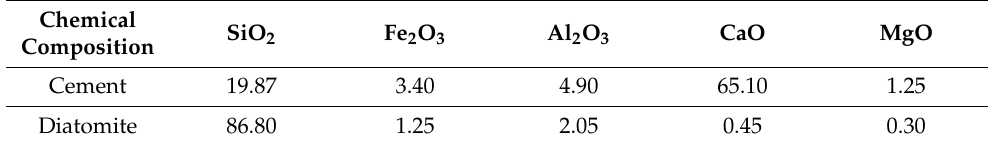
Table 2. Main chemical composition of diatomite and P.O42.5 cement (mass fraction).